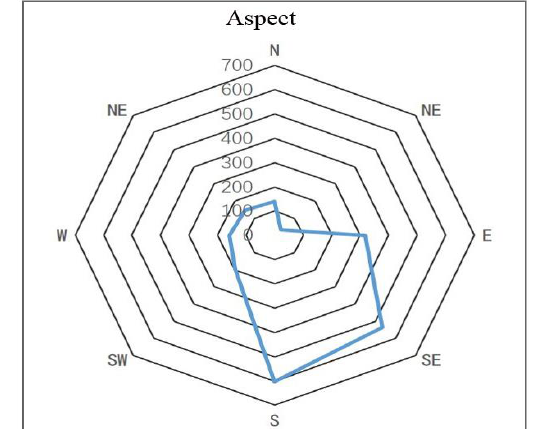
Figure 9. Relationship between geological hazards and